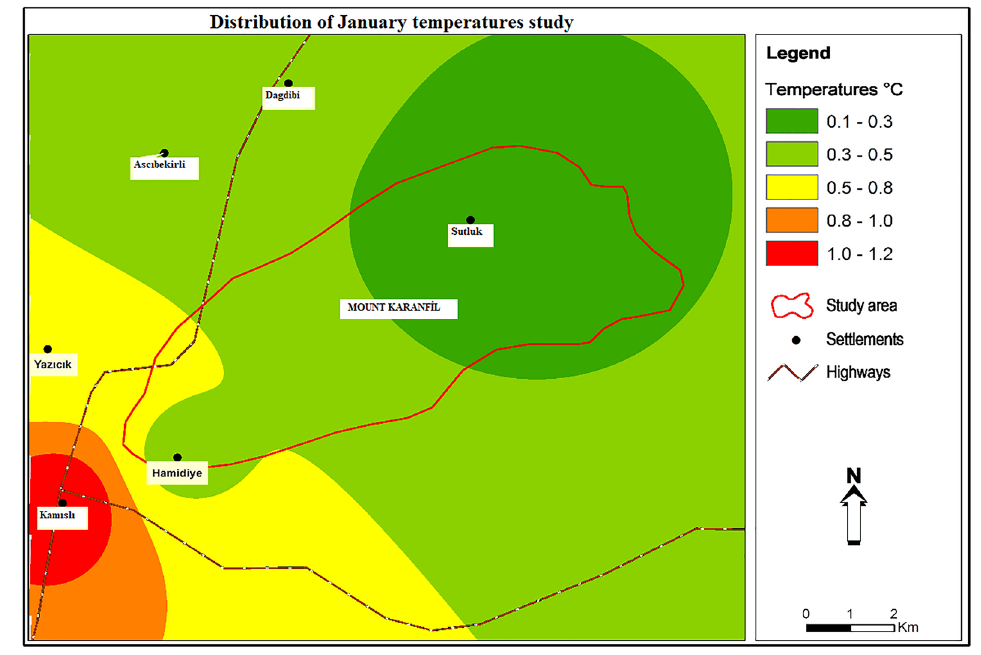
Fig. 10 Distribution of January temperatures study area